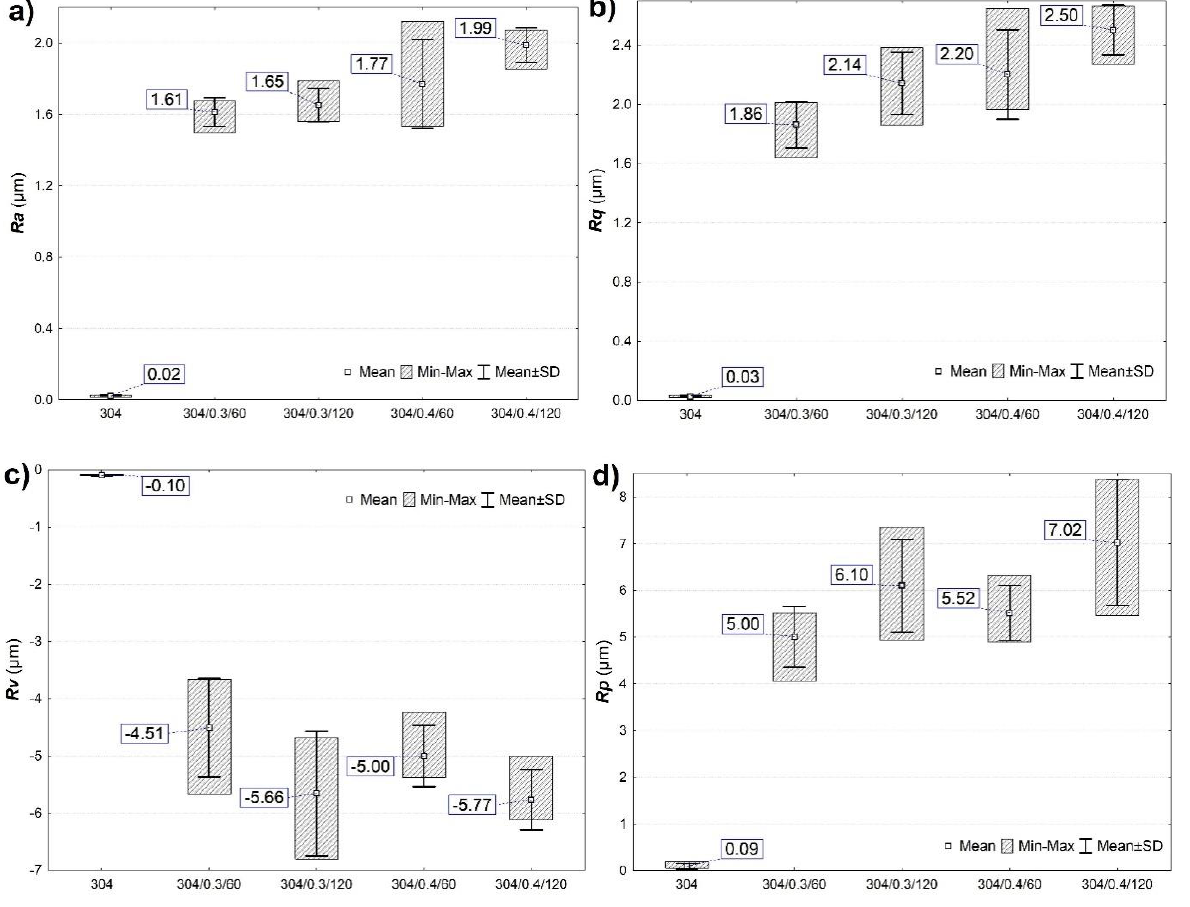
Figure 2. Roughness parameters: ( a ) Ra, ( b ) Rq, ( c ) Rv, and ( d ) Rp of unpeened (marked as 304) and shot peened surfaces.